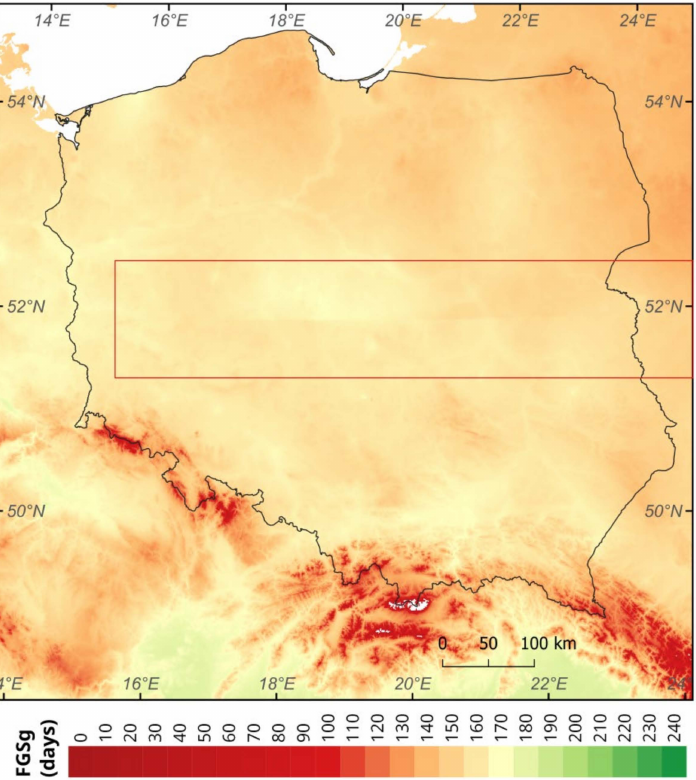
Figure 8. Visible discontinuity of FGSg calculated from WorldClim 2.1 dataset in Poland, associated with latitude 52 ◦